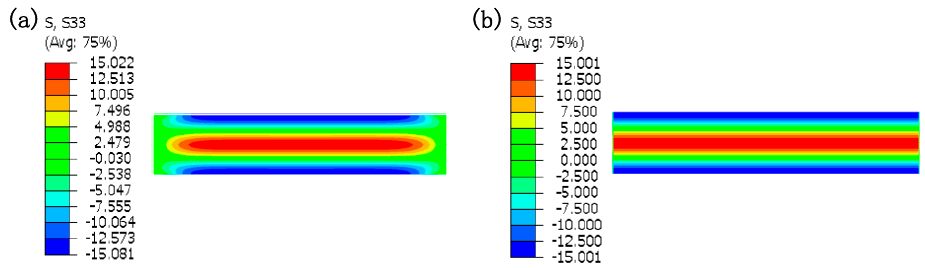
Figure 6. Longitudinal stress at a stable time calculated by different methods under a large aspect ratio of 5:1: ( a ) FEM; and ( b ) FE-IE coupling method.